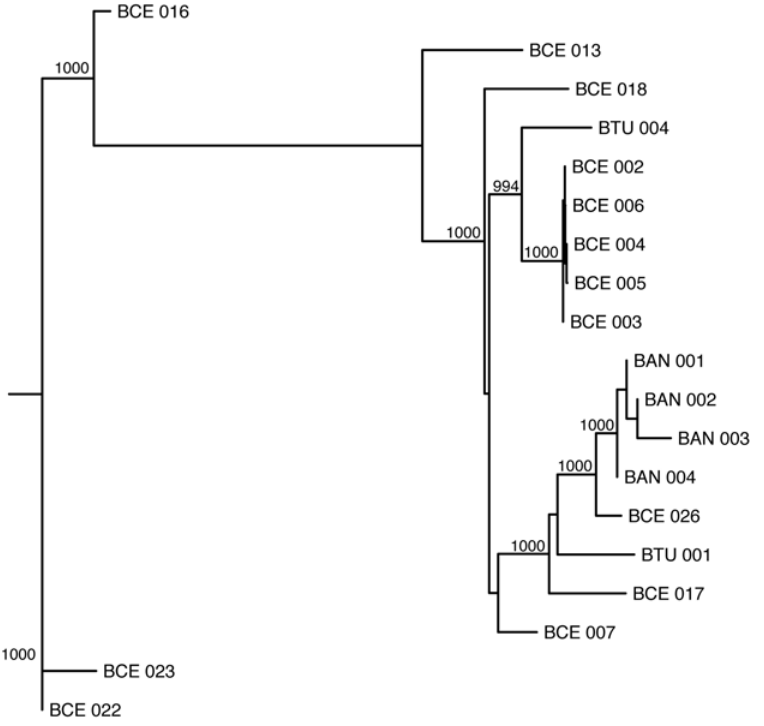
Figure 6. Neighbor-joining phylogenetic tree inferred using resequencing array (RA) data with a quality score threshold of 60 for a subsample of 19 Bacillus strains. Bootstrap values for nodes with greater than 99% support (1000 replicates total) are shown.